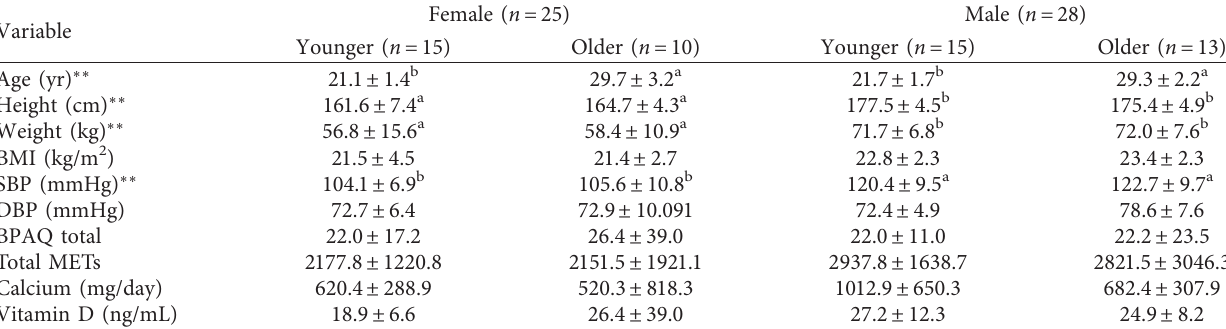
Table 1: Subject characteristics (mean ± SD).